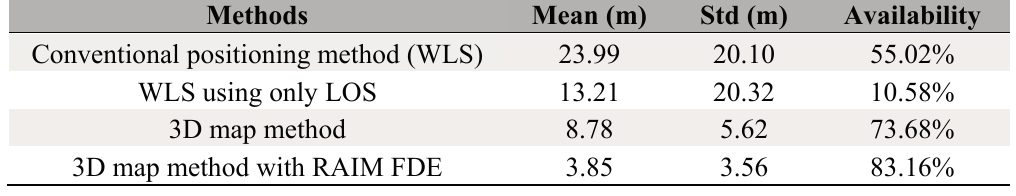
Table 4. Lateral positioning performance of the conventional method and the proposed 3D map method before and after using the RAIM method in the deep urban canyon.